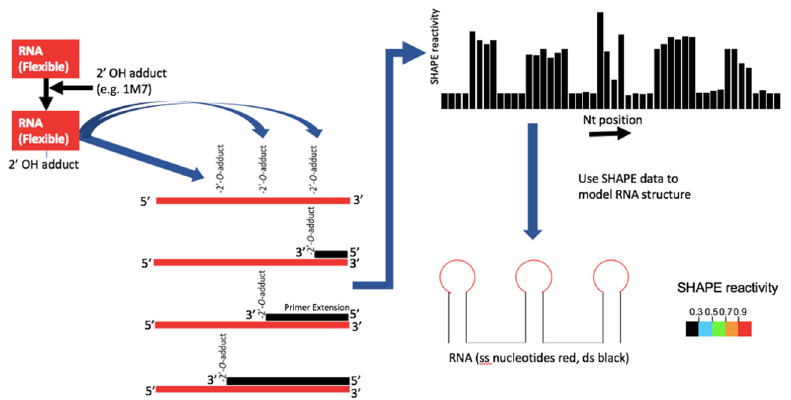
Figure 2. Process diagram for high-throughput SHAPE structure determination. The 1M7 reacts covalently with a 2 ′ OH on the sample RNA. This occurs preferentially where the backbone is flexible. Reverse transcriptase generates a family of cDNAs of length corresponding to the sites of 1M7 adduct formation. Comparison with a sequencing ladder allows readout of amount of cDNA product of each length. This ‘SHAPE reactivity’ is used to inform minimal free energy pre- diction